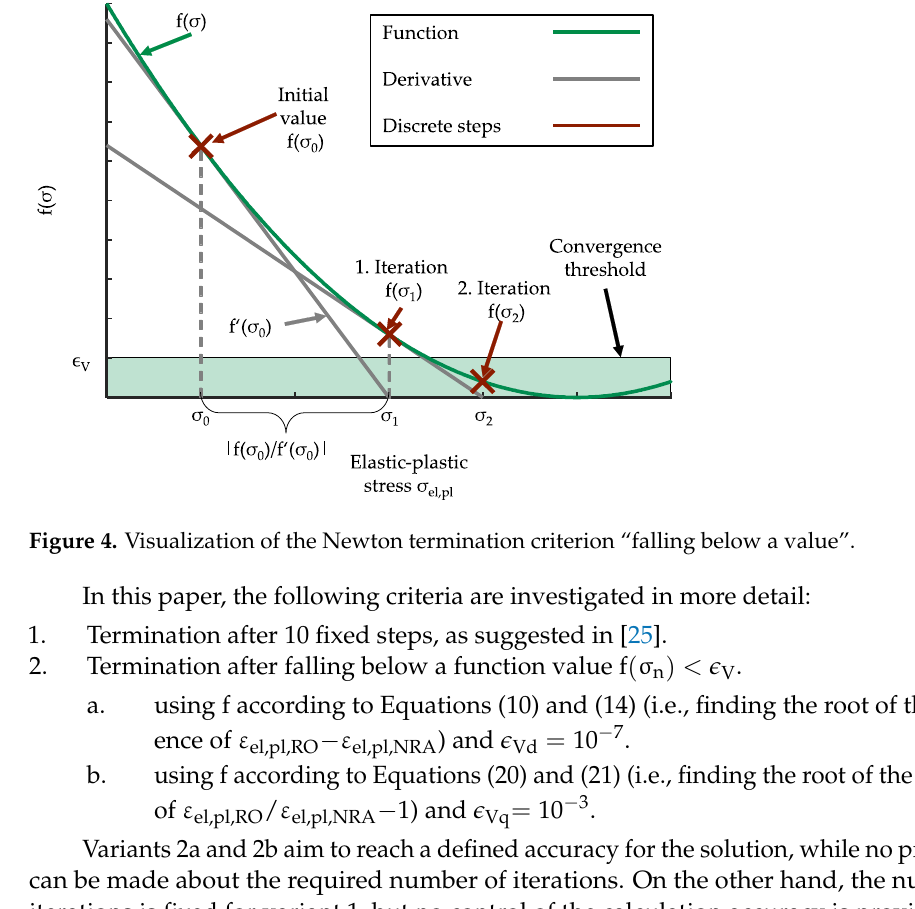
Table 1. Exemplary selection of parameters for which termination criteria 1 and 3 lead to complex values when applying the notch root approximation according to Seeger and Beste.